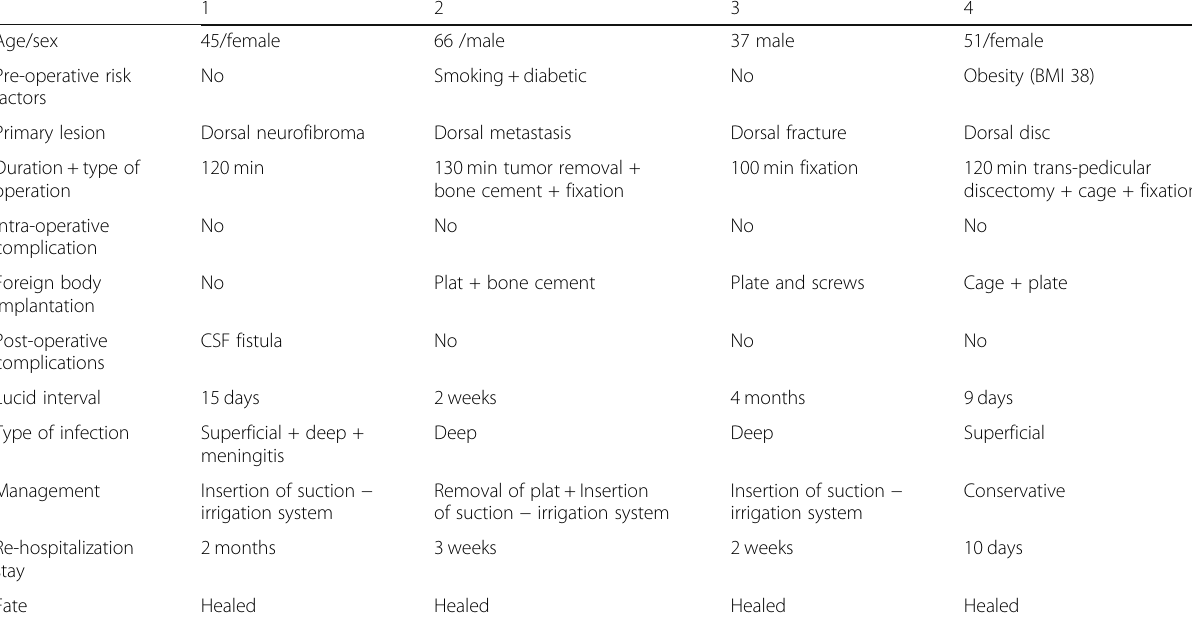
Table 2 Summary of the clinical data of dorsal